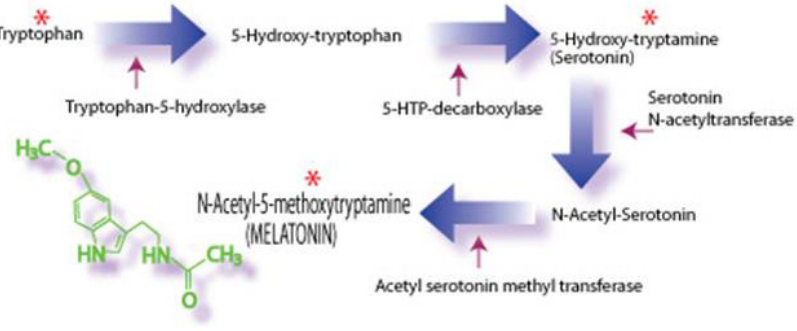
Figure 3. Schematic representation of the synthesis of melatonin from the amino acid, tryptophan. Tryptophan, which is taken up from the blood, via the four step pathway outline is converted to N -acetyl-5-methoxytryptamine (melatonin). Melatonin is best known for